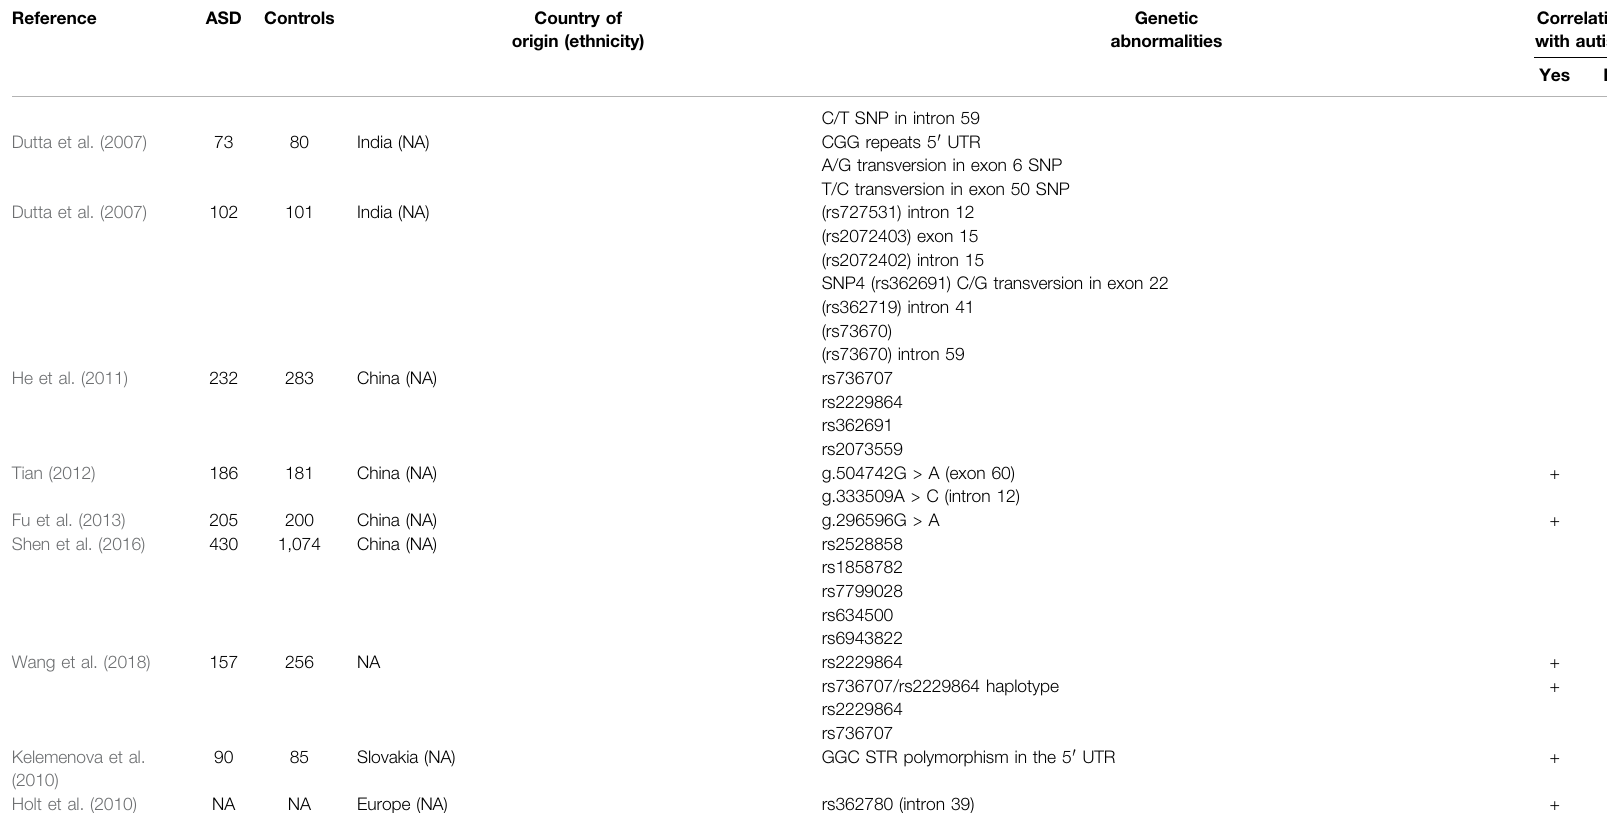
TABLE 1 | ( Continued ) Summary of the positive and negative RELN -ASD correlations in the published